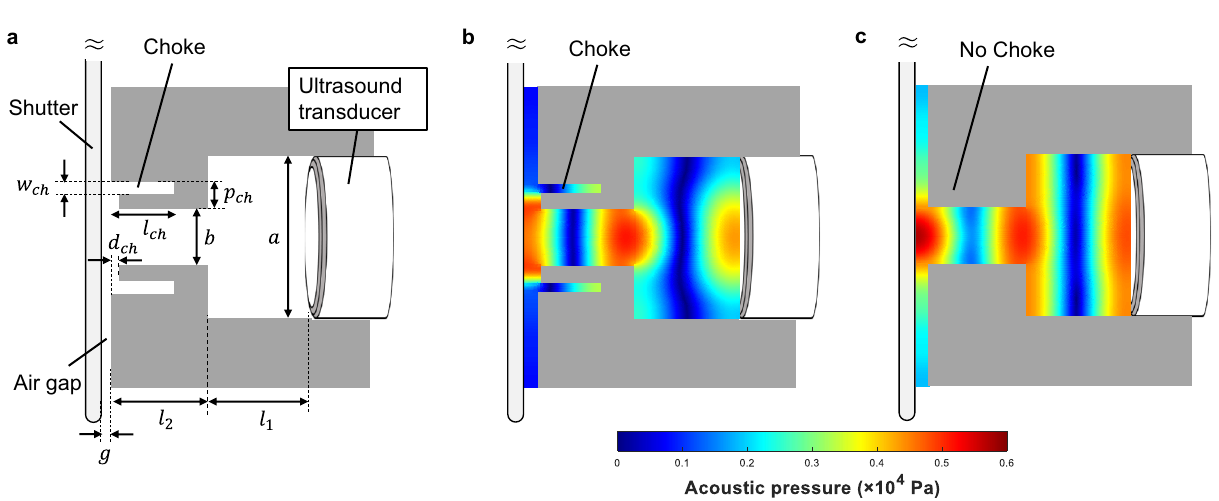
Figure 2. ( a ) Cross-section of the acoustic cavity including the choke structure. ( b ) Simulated acoustic pressure at 40 kHz with the choke structure. ( c ) Simulated acoustic pressure at 40 kHz without the choke